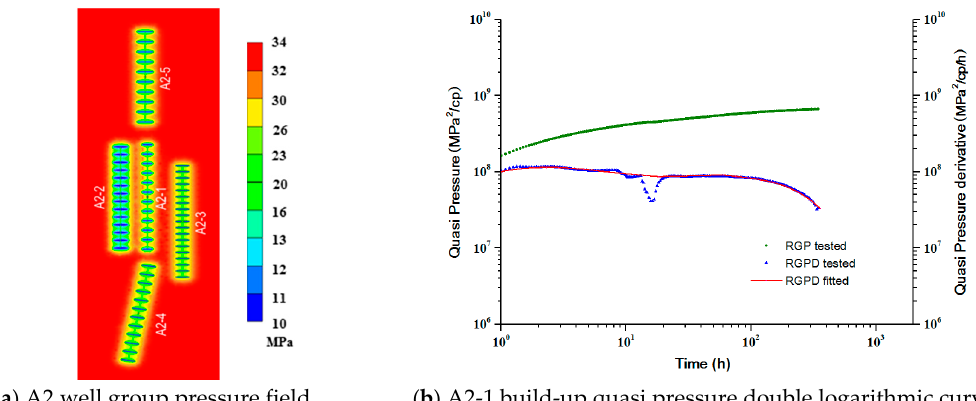
Figure 15. Numerical well of the simulation results of the simulated pressure field and the pseudo-logarithmic double logarithmic curve.